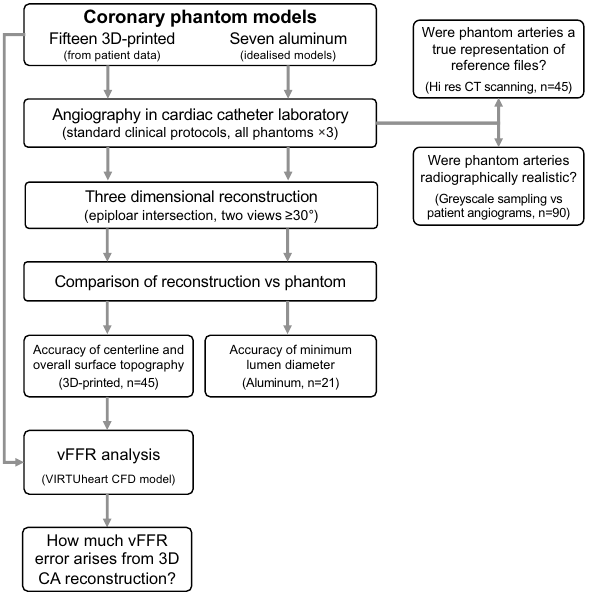
Figure 1. A flowchart demonstrating the experimental phantom arterial models, clinical imaging, 3D reconstruction, validation, vFFR simulation and